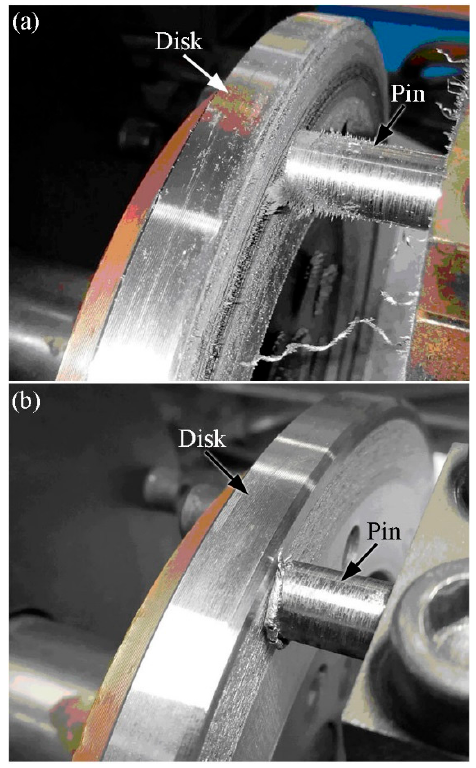
Figure 4. Appearance of the friction couple. ( a ) Without using RD and ( b ) using RD.